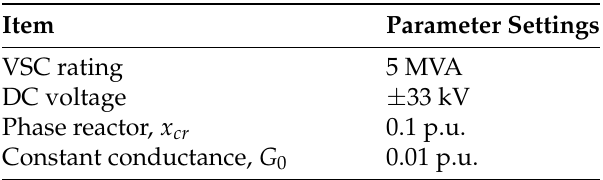
Table 1. Converter parameter